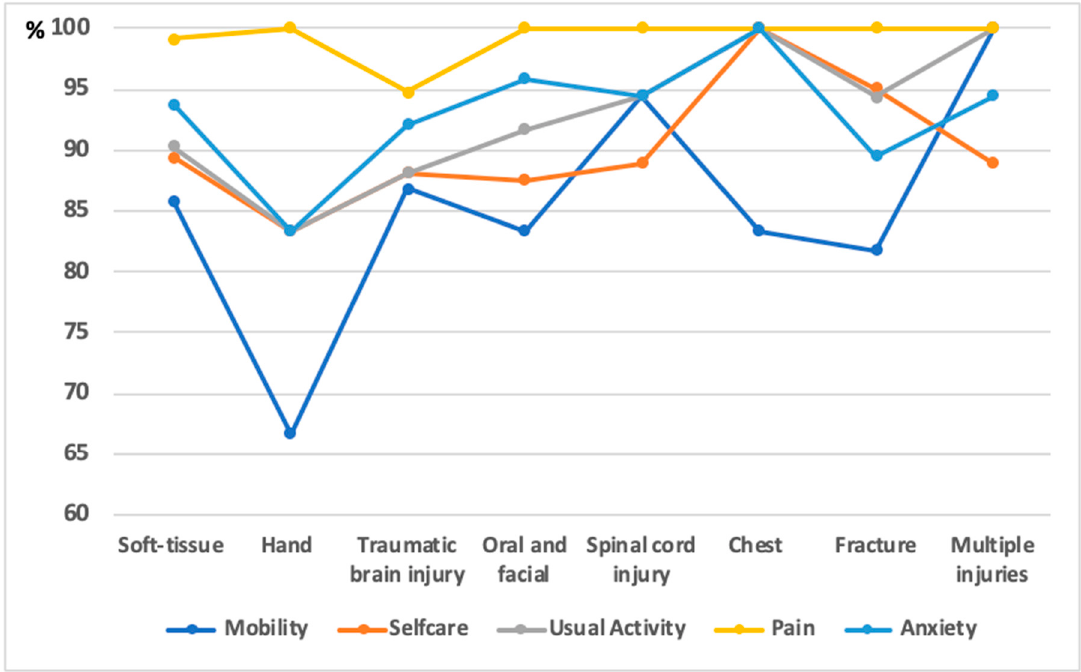
Figure 1. Health problems among the patients with different types of traffic injury.